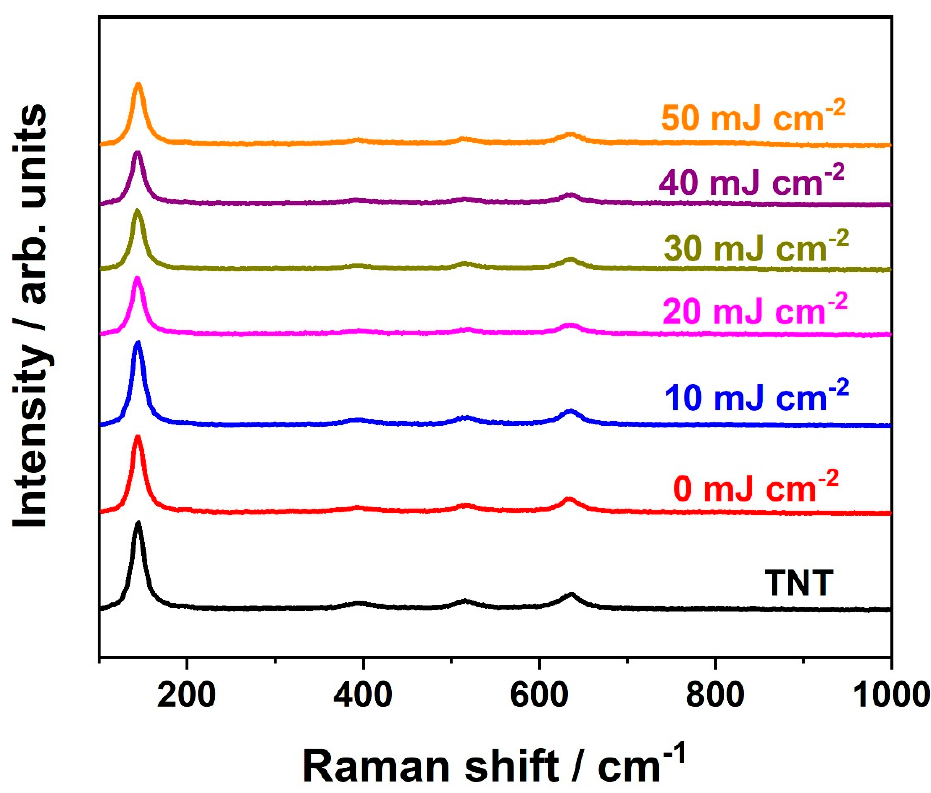
Figure 3. Raman spectra of the TiO 2 nanotubes decorated with chromium oxides before (0 mJ cm − 2 ) and after laser treatment (10–50 mJ cm − 2 ).